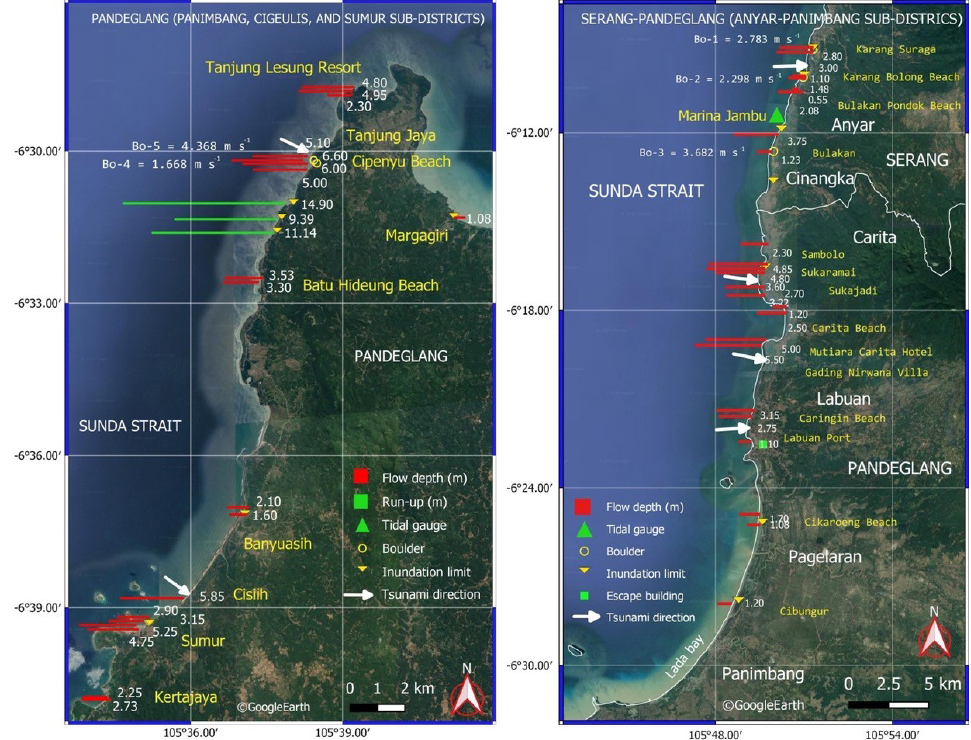
Figure 3. Tsunami flow depth distribution around Serang, the northern area of Pandeglang (a) and around southern Pandeglang (Panimbang– Sumur; b ). Flow depths are drawn in red bars. Green bars represent run-up heights. The green rectangle represents the location of a tsunami escape building at Labuan. (The map is adapted from Google